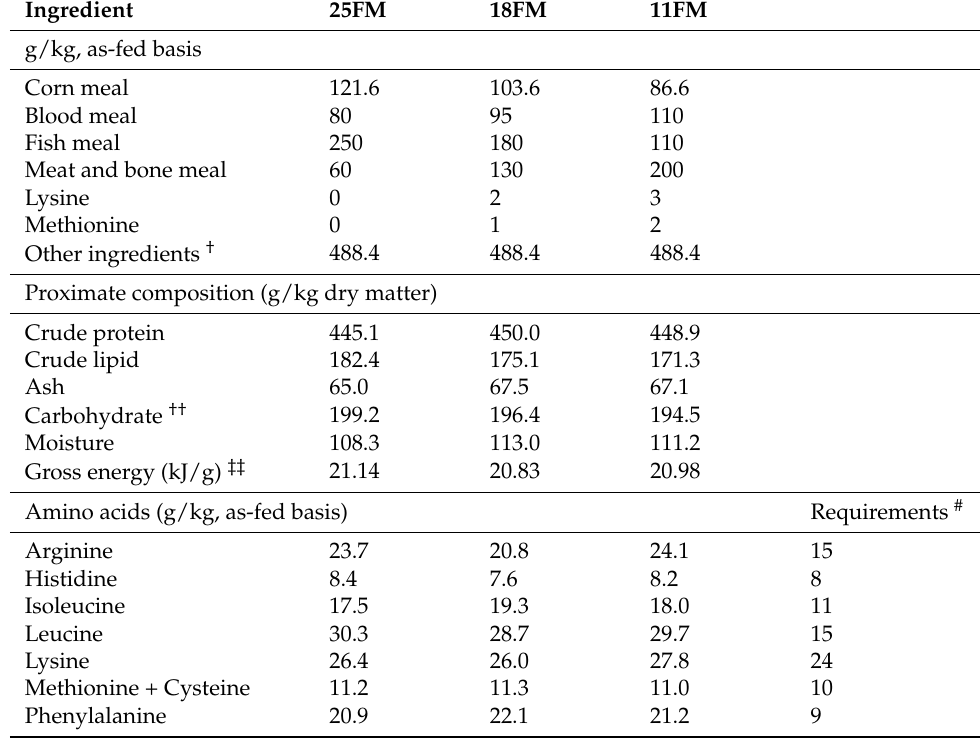
Table 1. Formulation and proximate analyses of the experimental diets replaced fish meal with meat and bone